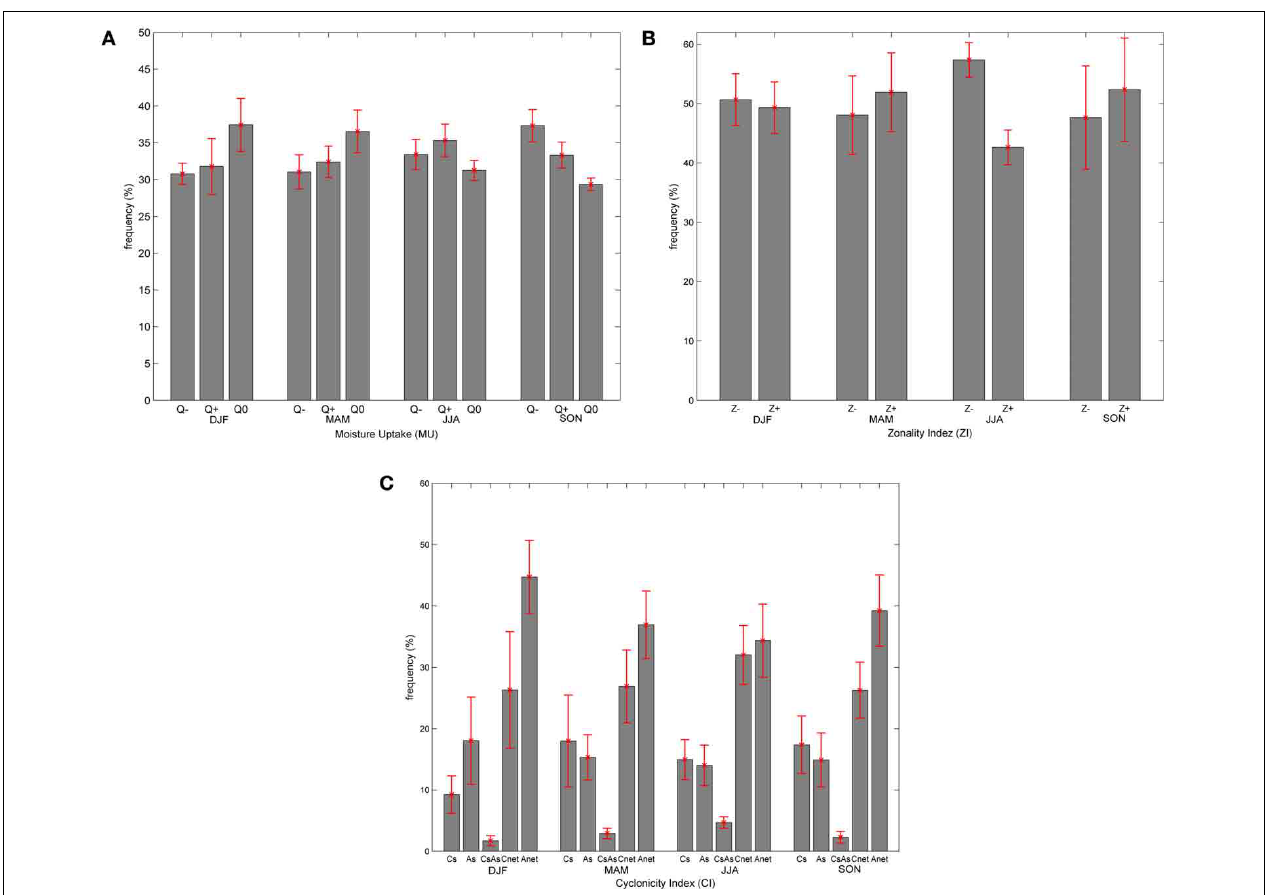
FIGURE 8 | Frequencies (%) of occurrence of the different characteristics for (A) Moisture Uptake (MU), (B) Zonal Index (ZI), and (C) Cyclonicity Index (CI), during winter (DJF), spring (MAM),